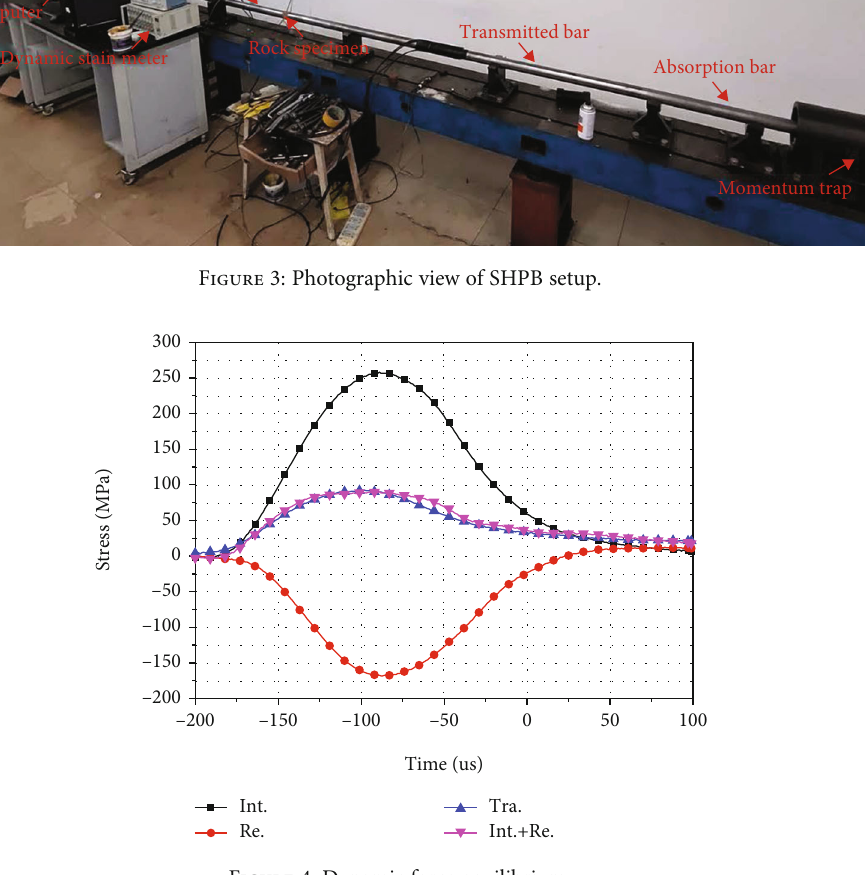
Figure 4: Dynamic force equilibrium.